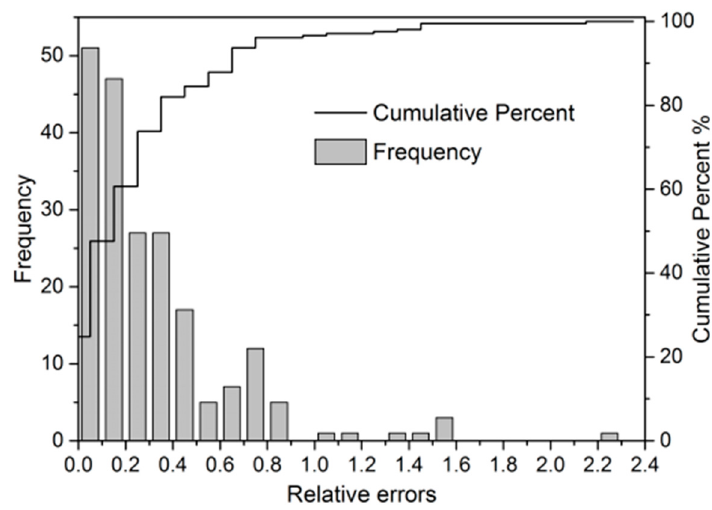
Figure 3. Frequency distribution and cumulative percentage of the relative errors (RE) derived from the leave-out-one cross validation (LOO-CV) of the regression model that had been used to calibrate the K d (PAR) from the concentration of TSM.